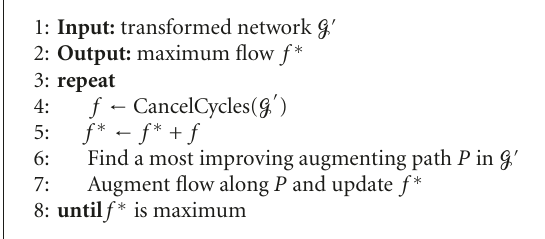
Figure 1: Node splitting.